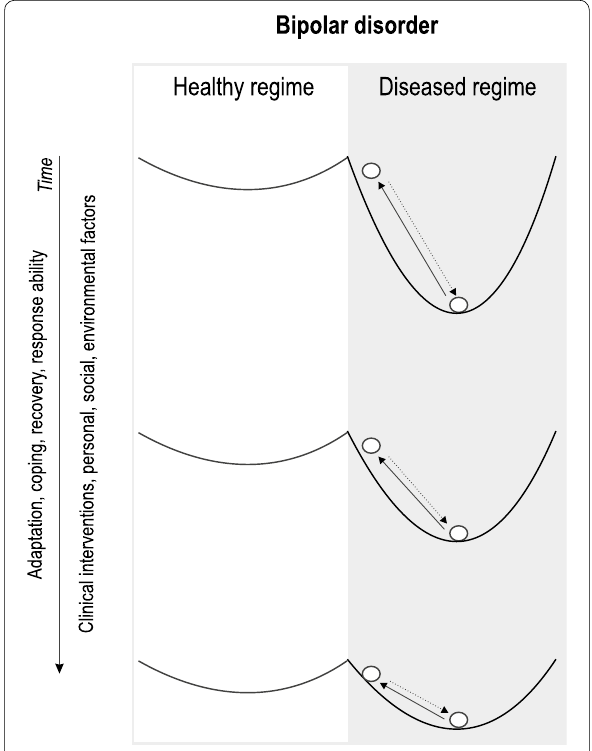
Fig. 3 Ball‑in‑cup heuristic showing how clinical practices among other factors can contribute to improve patients’ capacities to cope with, adapt to, and recover from mood episodes in the coerced state in the diseased regime of bipolar disorder by modulating the shape of the cup (basin of